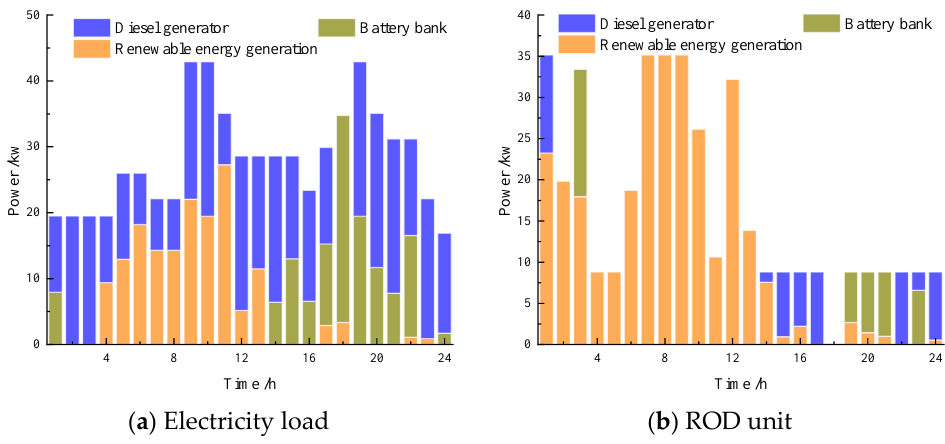
Figure 6. Operating schemes of the electricity load and the ROD unit.